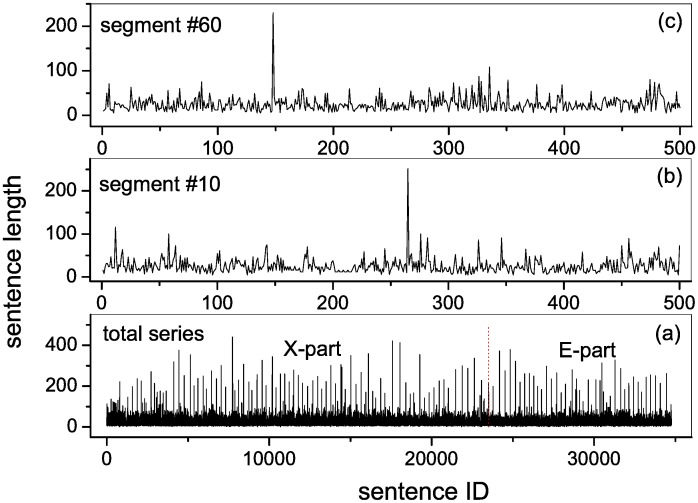
Sentence series.(a) The total sentence series. Every element is the sentence length, i.e, the number of characters covered by the corresponding sentence. The two parts written by Xueqin Cao (X-part) and E Gao (E-part) are separated by a vertical red dotted line. (b) The segment of sentence series numbered seg10. (c) The segment of sentence series numbered seg60. The total sentence series is separated into a total of 69 non-overlapping segments with a length of 500 sentences each, numbered with seg01, seg02, ⋯, seg69 respectively.